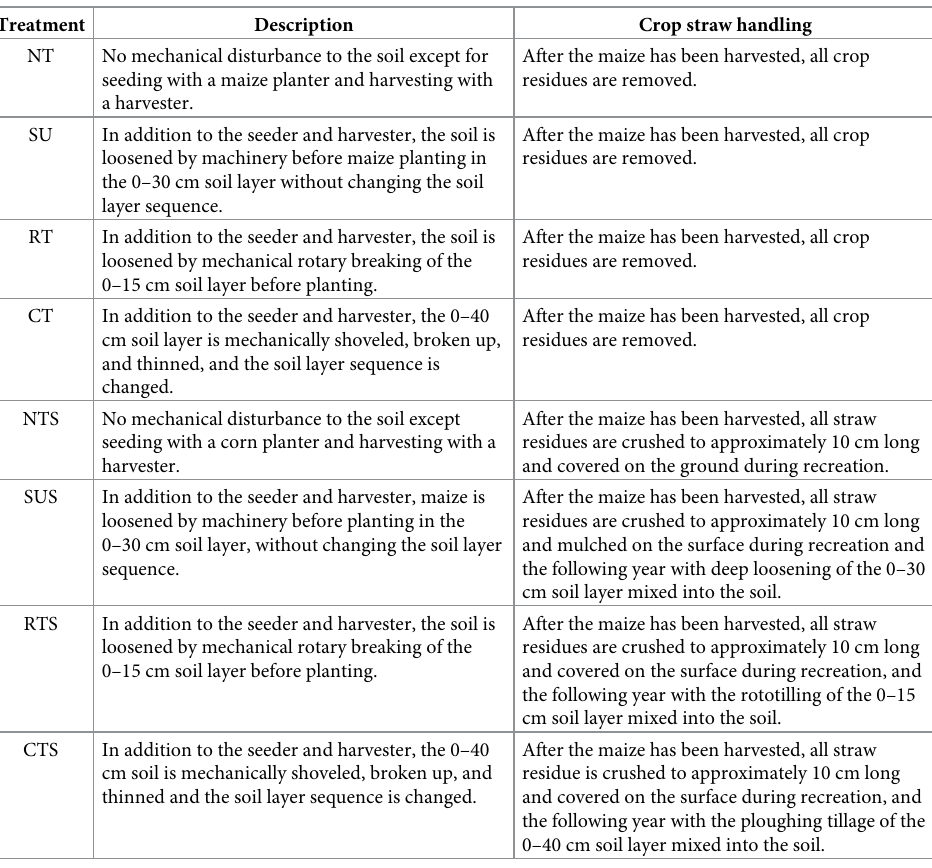
Table 2. Details of tillage